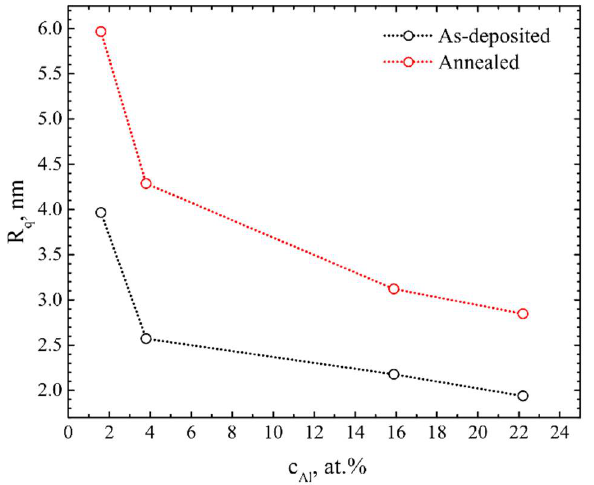
Figure 5. Surface roughness of ScAlSZ thin films: ○ as-deposited and ○ after annealing. Thin films were annealed, and in situ XRD measurements were taken at different temperatures from 30 to 900 °C to investigate changes in crystalline structure (Figure 6). The phase transitions and increase of crystallinity occurred above ~500 °C, i.e., the peaks in the XRD patterns appeared and/or the intensity of the peaks increased. However, it was not possible to determine the exact phase transition nature due to overlapping peaks of cubic, tetragonal, monoclinic, and rhombohedral phases from XRD measurements. It is only possible to presume that the amount of tetragonal phase increases when Al concentration is 15.9 at.%, and the amorphous phase transforms to cubic, tetragonal, and rhombohedral phase mixture when Al concentration is 22.2 at.%. Figure 6. XRD patterns of ScAlSZ thin films during annealing process containing different Al concentration: ( a ) 15.9 at.% and ( b ) 22.2 at.%.